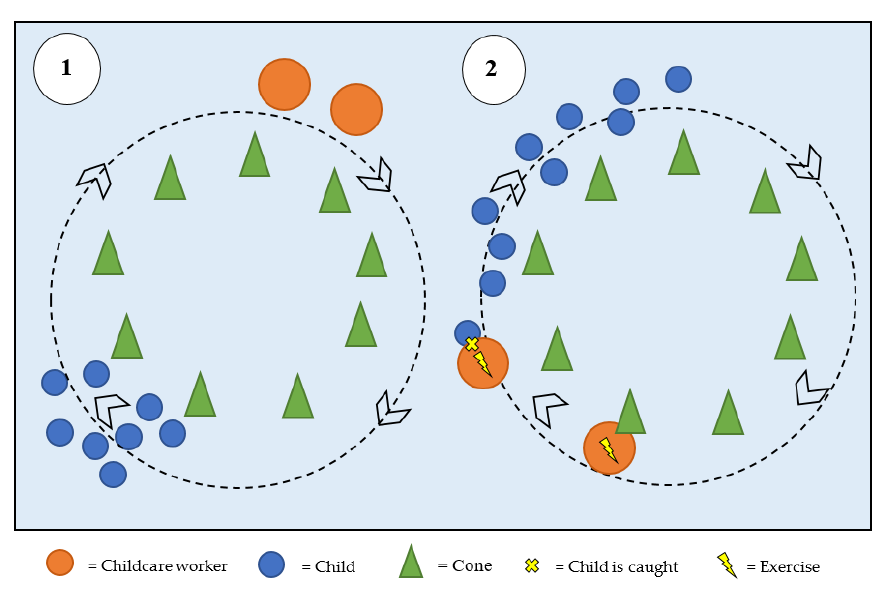
Figure A2. The Rabbit hunt. Further details in the Figure 2. The Rabbit hunt. Further details in the text.